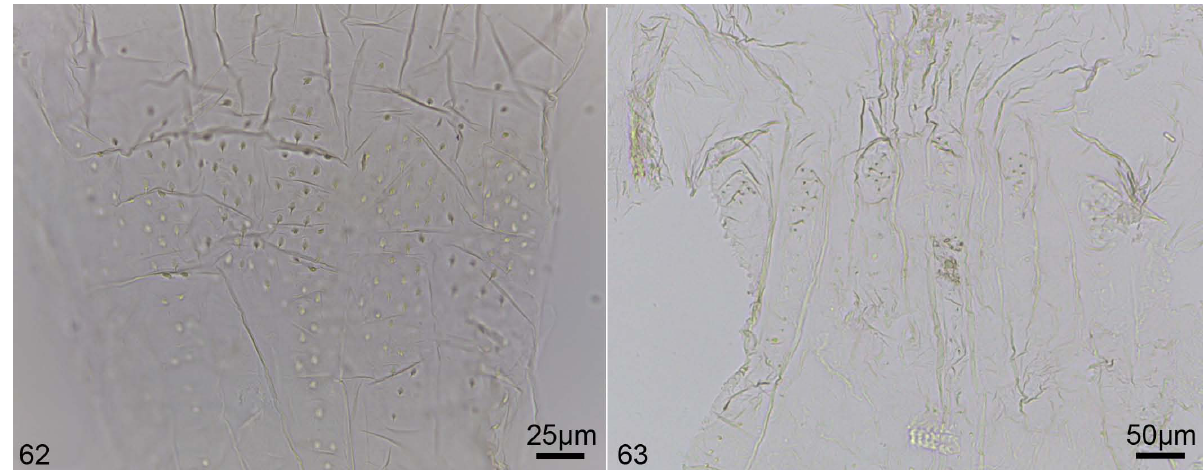
Figs 62–63. Enteric valve armature of: 62- Amitermes amifer ; 63- Gnathamitermes perplexus